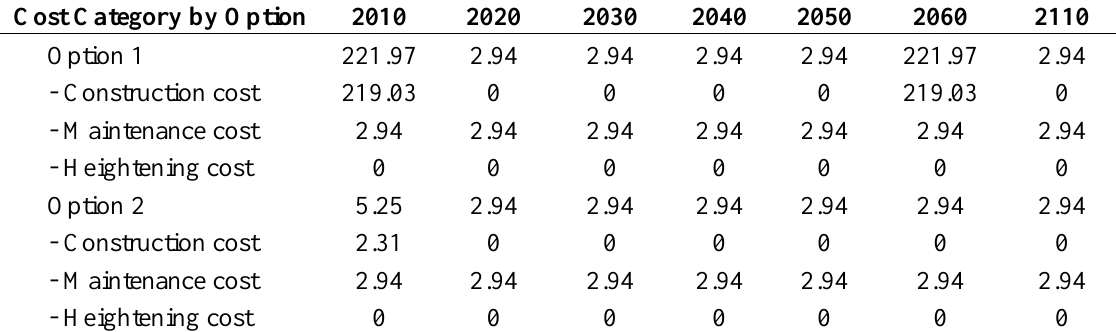
Table A9. Costs of dike options (million